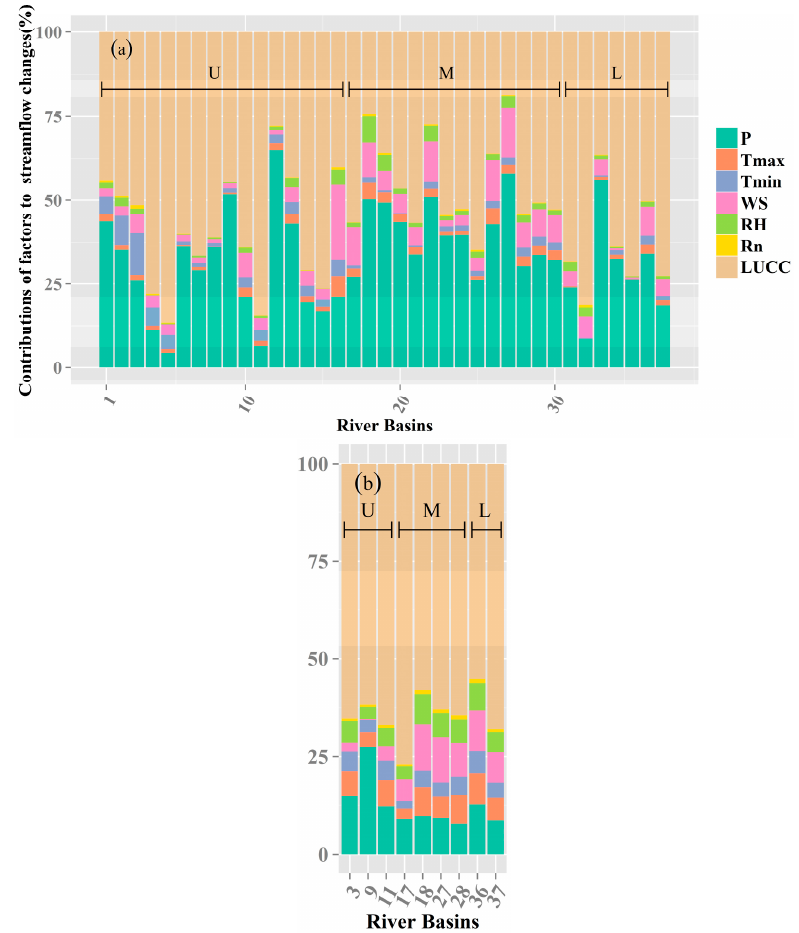
Figure 5. Changes in the fractional contributions of various influencing factors and their relative impact on changing streamflow between Period 2 and Period 1 ( a ) and between Period 3 and Period 1 ( b ) across the Yellow River basin. Note: data was only available for nine stations for Period 3. U = upper reaches, M = middle reaches, and L = lower reaches.